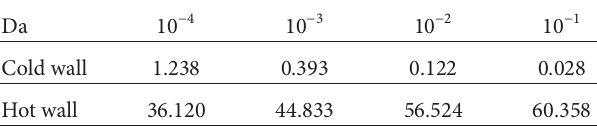
Table 3: Average Nusselt numbers at the hot and cold wall for different Darcy numbers.